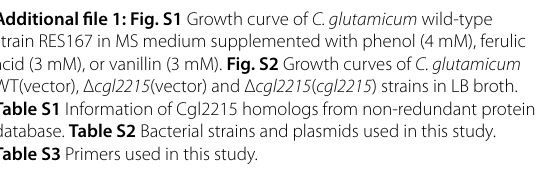
Table S1 Information of Cgl2215 homologs from non-redundant protein database. Table S2 Bacterial strains and plasmids used in this study. Table S3 Primers used in this